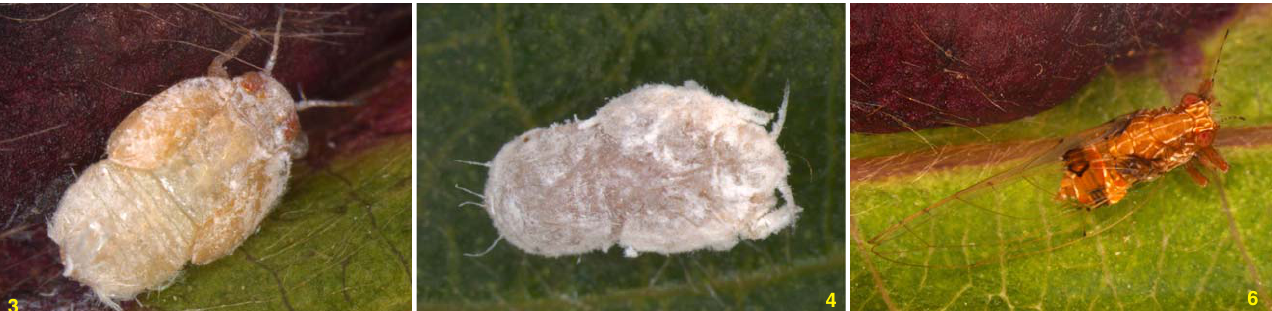
Image 2. Whole leaf rolled into a gall- like structure